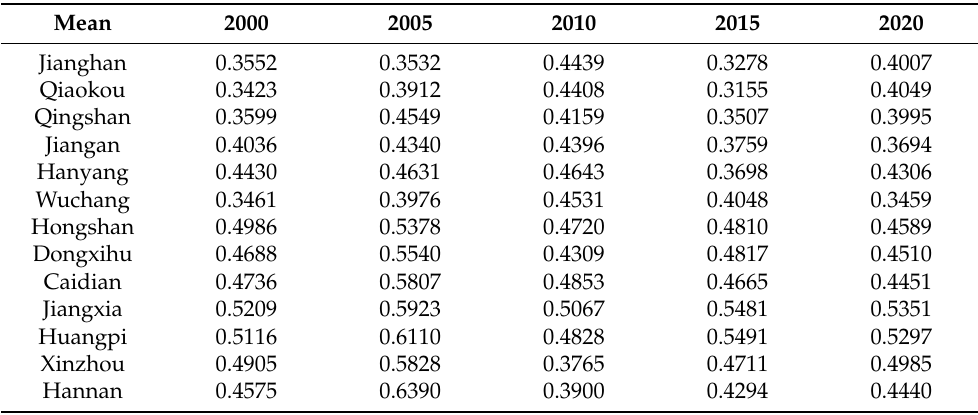
Table 3. The WIRSEI in each district of Wuhan from 2000 to 2020.